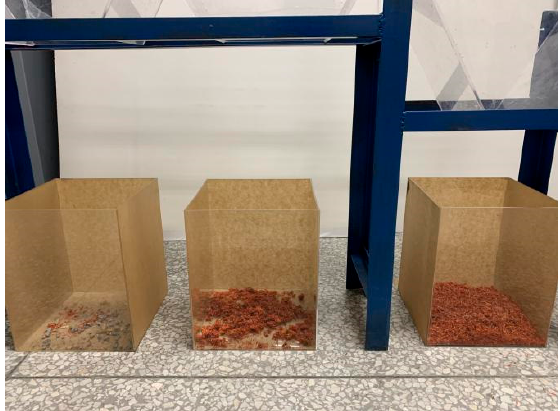
Figure 22. Experiment